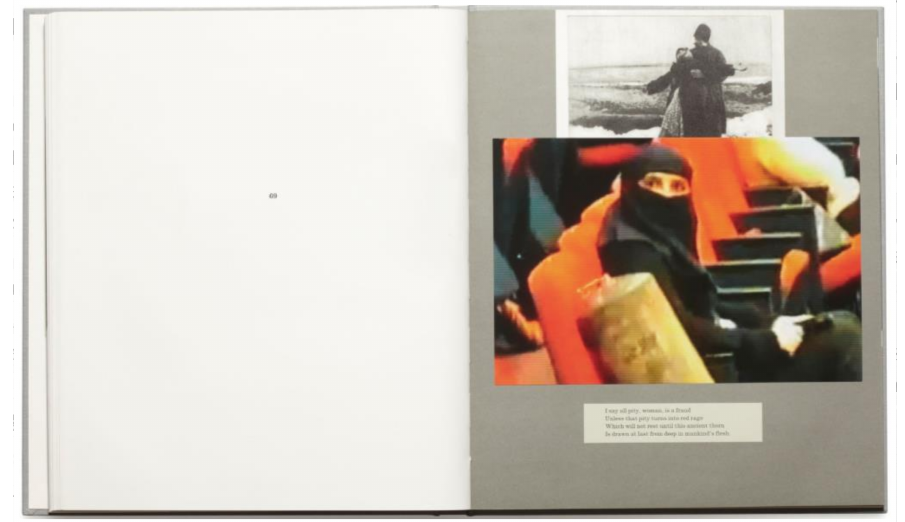
Figure 6. Plate 69. Broomberg & Chanarin. 2011. War Primer .